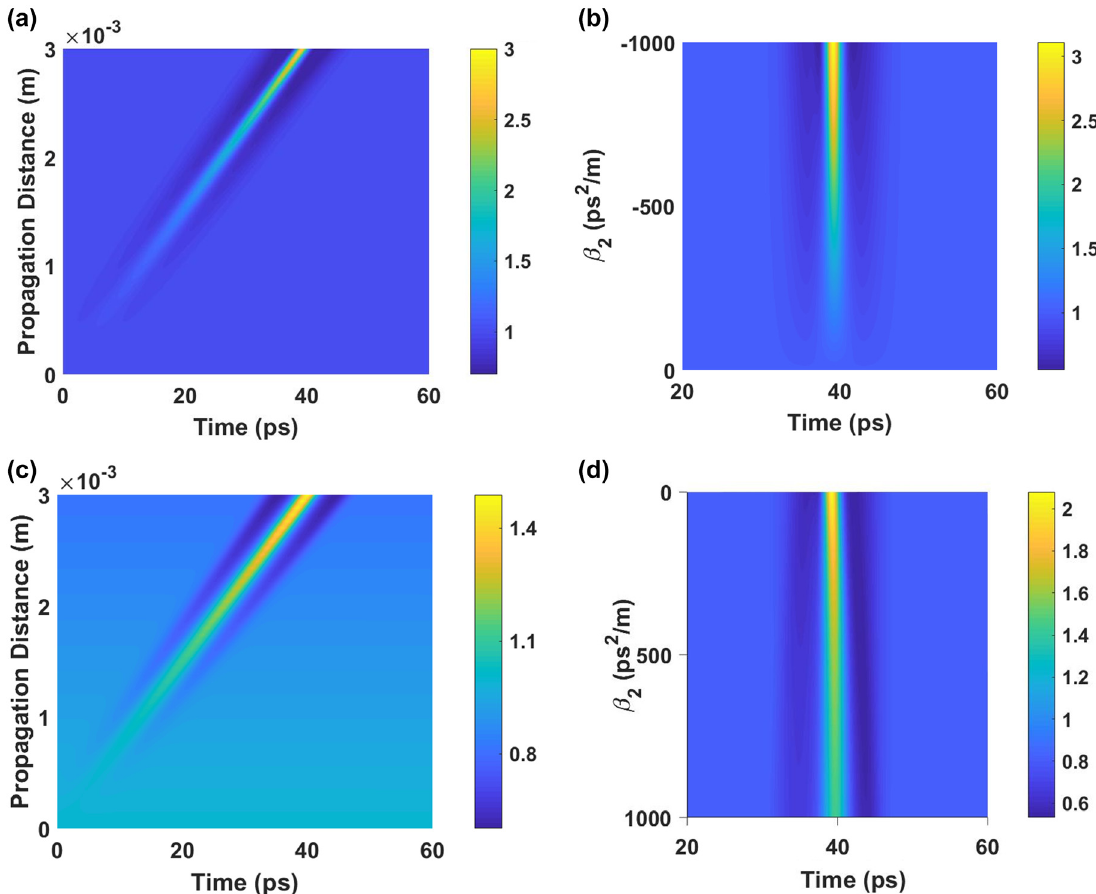
Figure6: Numericalcalculationsofthetemporaldynamics.(a)SignalwaveformasafunctionofpropagationdistanceforConfiguration1,and (c) similar but for Con fi guration 2. (b) Signal waveform versus probe dispersion, β 2 in Con fi guration 1 (d) signal waveform versus pump dispersion, β 2 in Con fi guration 2. Color bars denote probe power in